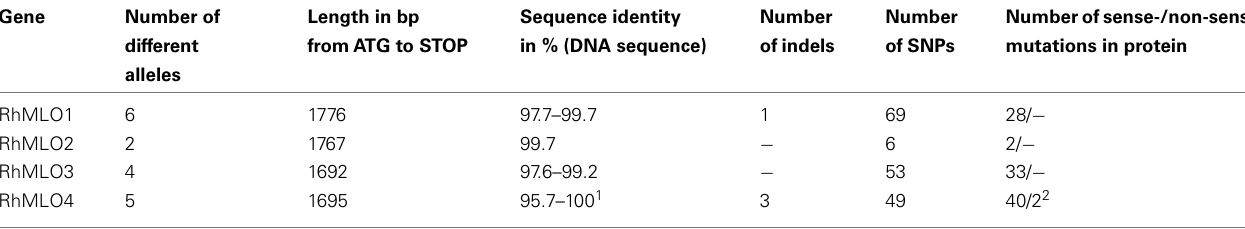
Table 1 |Alleles of RhMLO1–RhMLO4 that were isolated from four rose genotypes.